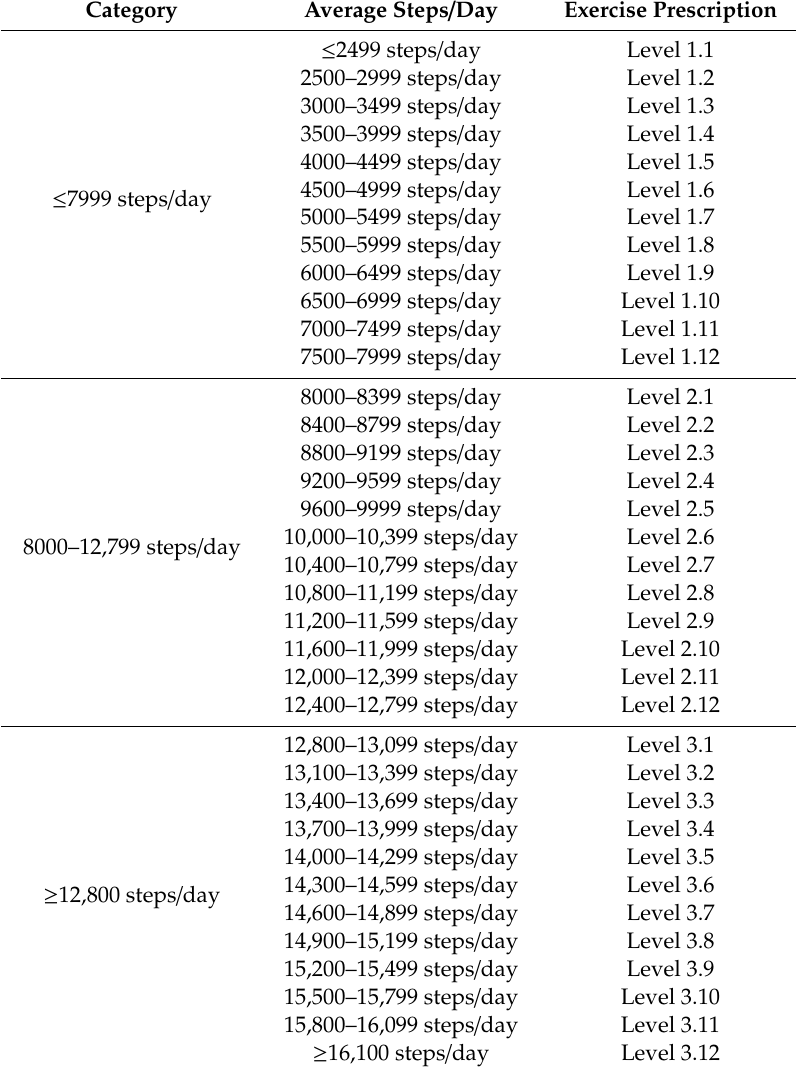
Table 1. Categories of exercise